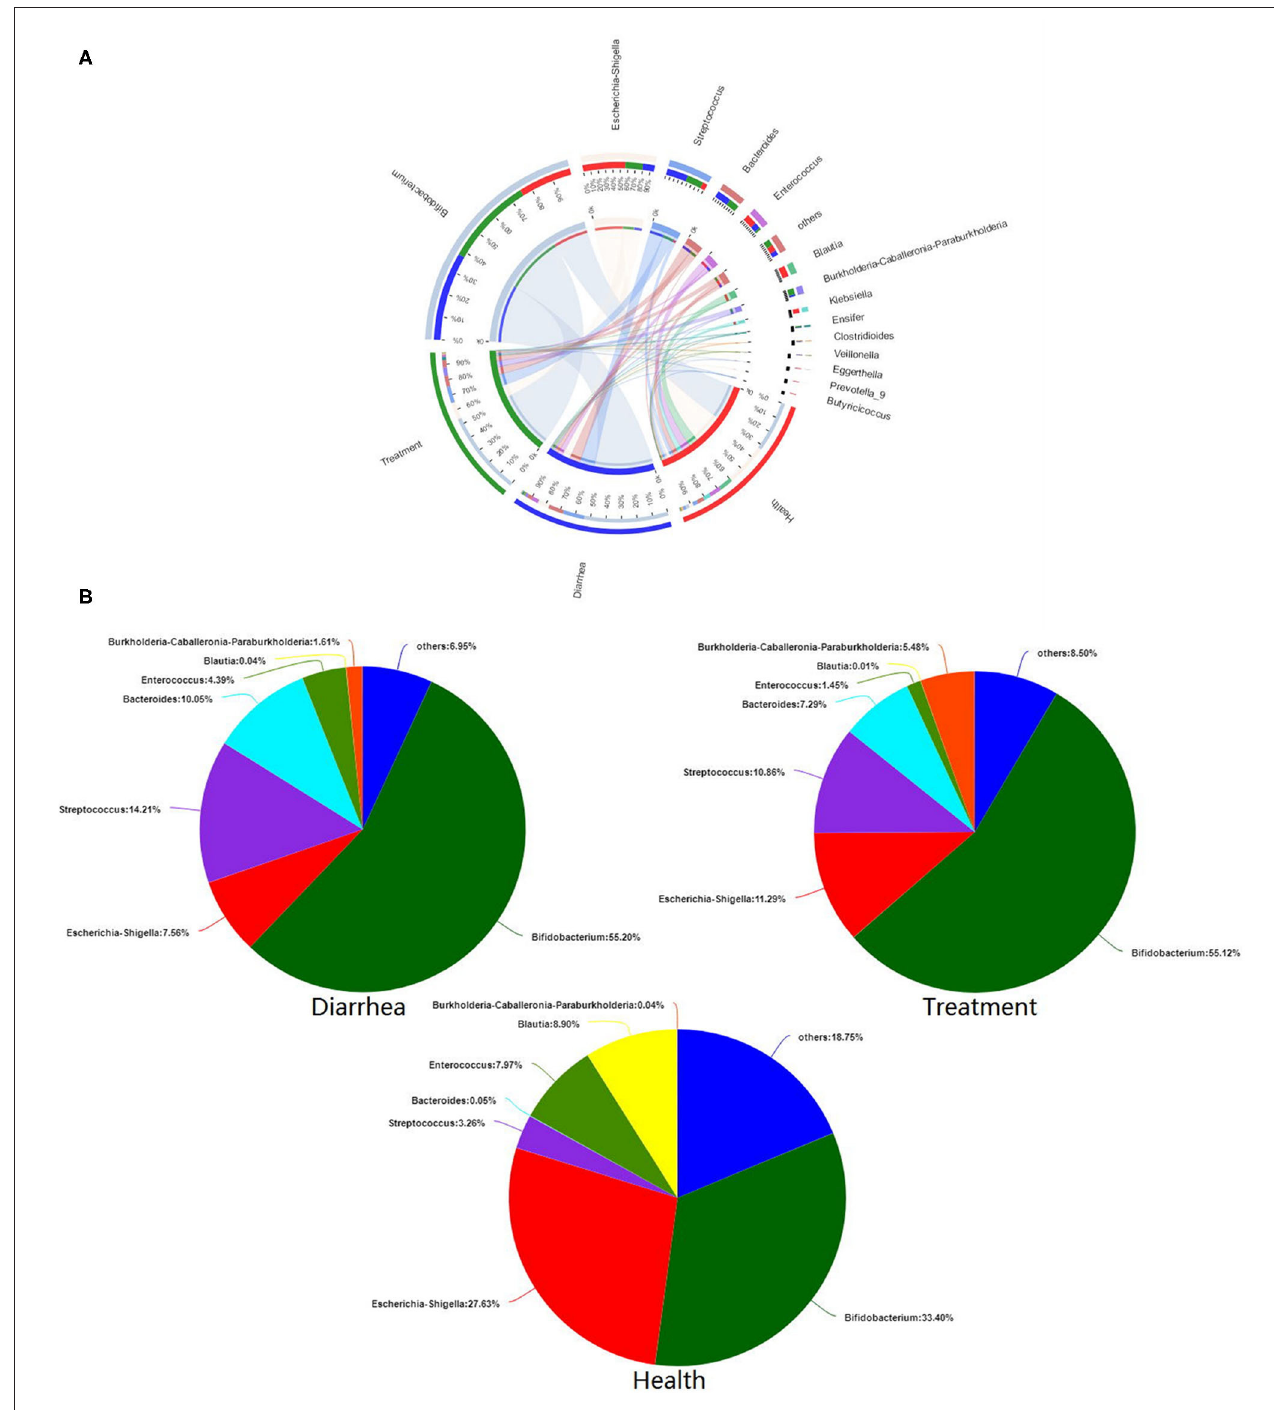
FIGURE 6 | The effects of L. casei ZX633 on the gut microbiota of infants with diarrhea. (A) A circos plot shows the linkage between samples and bacterial genera. (B) Pie charts show gut microbial composition recovery after L. casei ZX633 treatment.